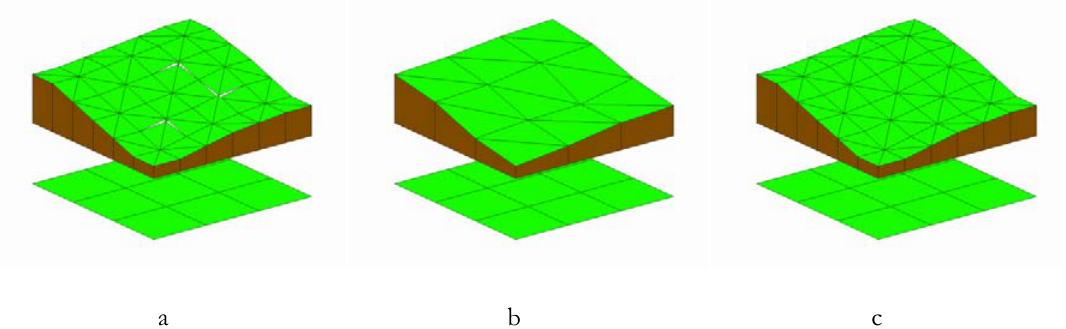
Figure 2. Polyhedral approximations of the original terrain.